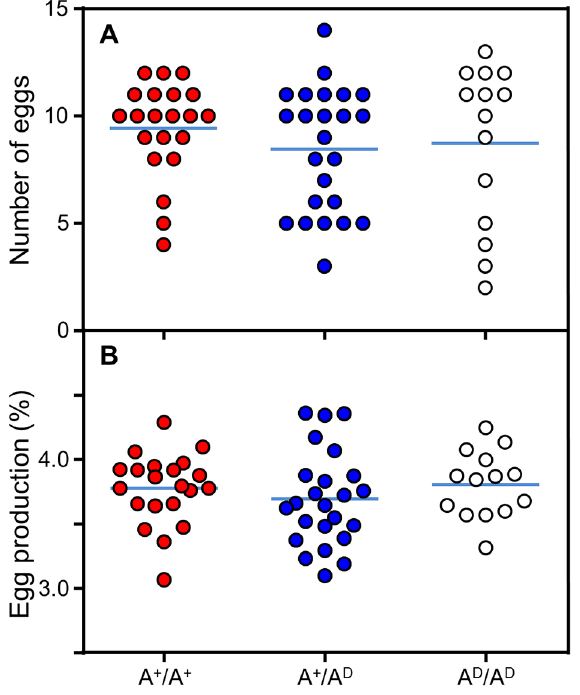
Figure 2. Fecundity results from the different genotypes of the F 10 intercross strain. A) total egg count during the 2 week collecting period and B) total egg mass as a percent of body mass. A + /A + is wild type, A + /A D is heterozygote and A D /A D is domestic genotype. The horizontal line shows the mean value and the dots are the individual data points.